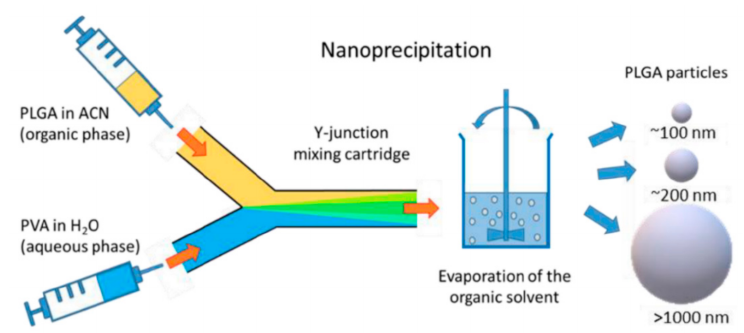
Figure 19. Schematic representation of the particle generation process via nanoprecipitation method using a Y-junction mixing cartridge. ACN: acetonitrile; PLGA: poly(lactic-co-glycolic acid); PVA: polyvinyl alcohol. Reprinted from an open-access source